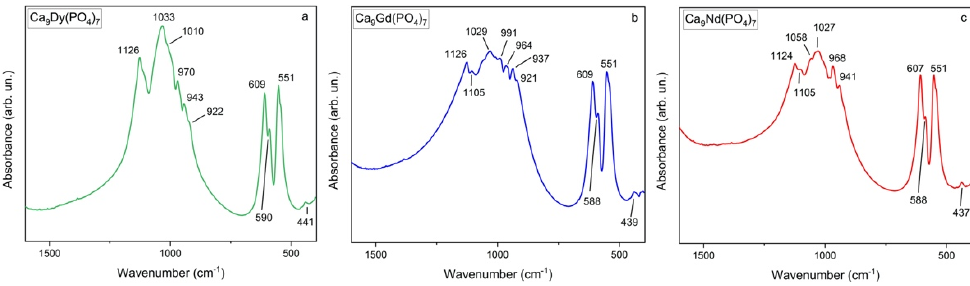
Figure 7. FTIR spectra of ( a ) Ca 9 Dy(PO 4 ) 7 , ( b ) Ca 9 Gd(PO 4 ) 7 , and ( c ) Ca 9 Nd(PO 4 ) 7 in the 1600–400 cm − 1 region.